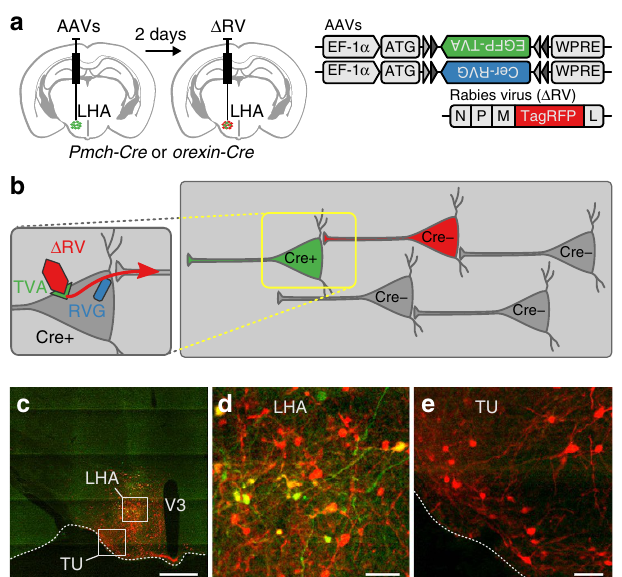
Figure 3 | Strategy for genetically specified tracing of monosynaptic inputs to LH cells. ( a ) Scheme for targeting monosynaptic retrograde tracing components (Cre-dependent RVG and TVA, followed by rabies D RV than can only infect cells expressing TVA). ( b ) Scheme for monosynaptic retrograde tracing processes. Monosynaptic input neurons to Cre-positive cells (green) become selectively labelled with RFP (red), because the rabies-RFP ( D RV) can only cross synapses if the infected cell contains the Cre-dependent RVG (zoom). ( c ) An example of a coronal brain section from a Pmch-Cre mouse expressing fluorescent proteins delivered by viral vectors as indicated in a , b . MCH neurons (green, yellow) and their direct input neurons (red), scale bar, 1mm. Representative example from six brains. ( d ) Higher magnification image from c (LHA), scale bar, 200 m m. ( e ) Higher magnification image from c (TU), scale bar 200 m m. nucleus, and proopiomelanocortin in the hypothalamic arcuate nucleus (Supplementary Fig. 4C). Two especially striking hotspots of MCH input neurons corresponded to